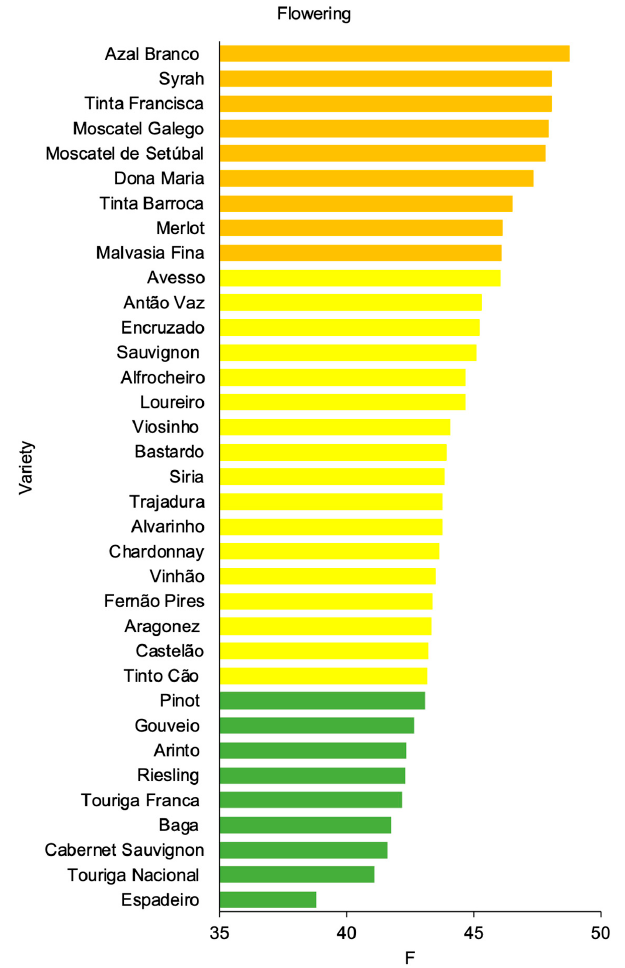
Figure 6. Ranking of the F measure for budburst by grapevine variety in the Lisboa wine region. Only models with efficiency coefficient (EF) ≥ 0.5 are shown.